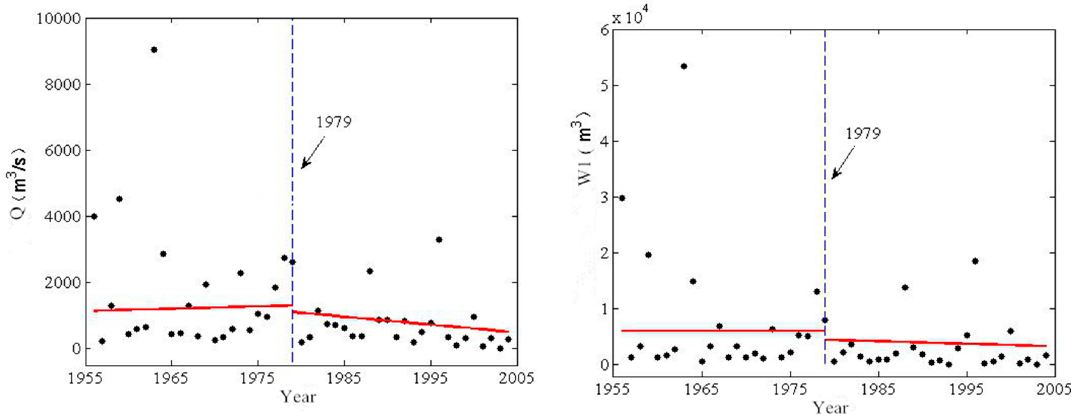
Figure 2. Trend test results of the flood subsequences with consideration of change point.